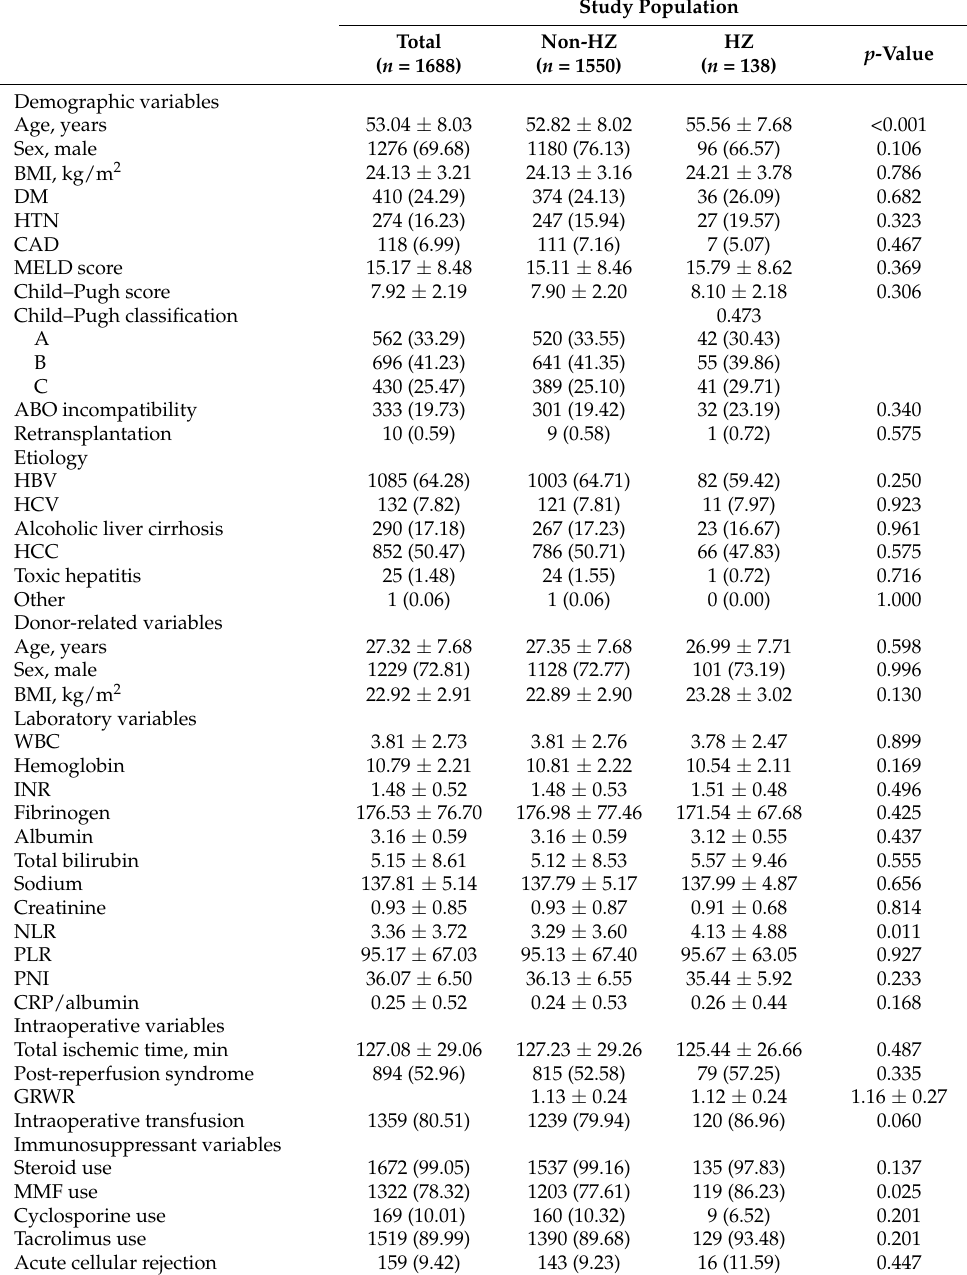
Table 1. Cox regression analysis of the risk factors associated with herpes